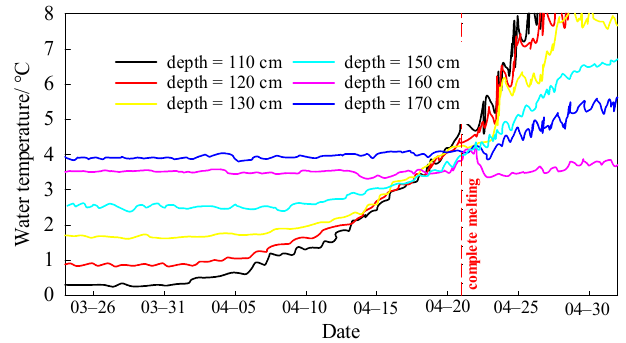
Figure 5. Variations of water temperatures during the late